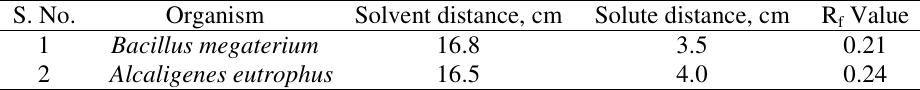
Table 2 . R value for the production of PHB from sugarcane effluent in industrial waste f medium